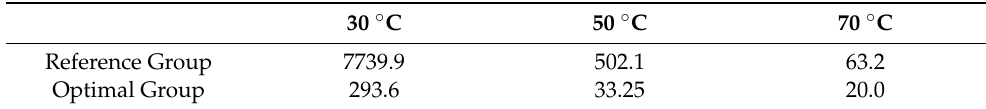
Table 4. Interface resistance of the Reference Group and the Ultrasonic Group at different tempera- tures ( Ω · cm 2